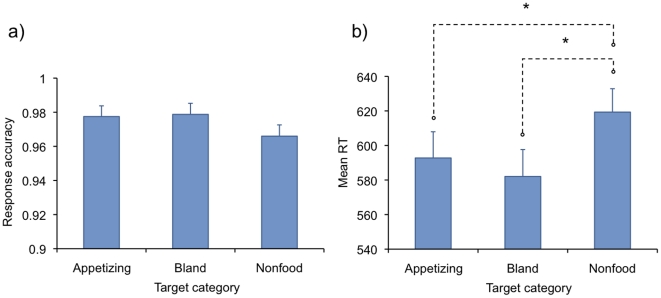
Means and standard errors of the response accuracy (a) and reaction times (b) on target-present trials, as a function of target type in Experiment 1.The asterisk denotes a significant difference (p<.05).